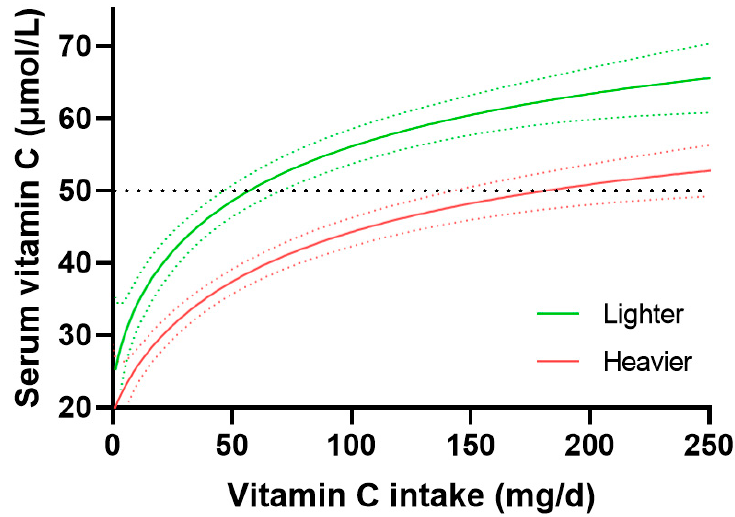
Figure 4. Vitamin C dose-response relationship relative to body weight. Lighter weight tertile 63 (57, 68) kg, n = 932; heavier weight tertile 105 (67, 118) kg, n = 930. Sigmoidal (four parameter logistic) curves were fitted to the dose-concentration data with asymmetrical 95% confidence intervals indicated. Dashed line indicates 50 µmol/L serum vitamin C, which is considered ‘adequate’.